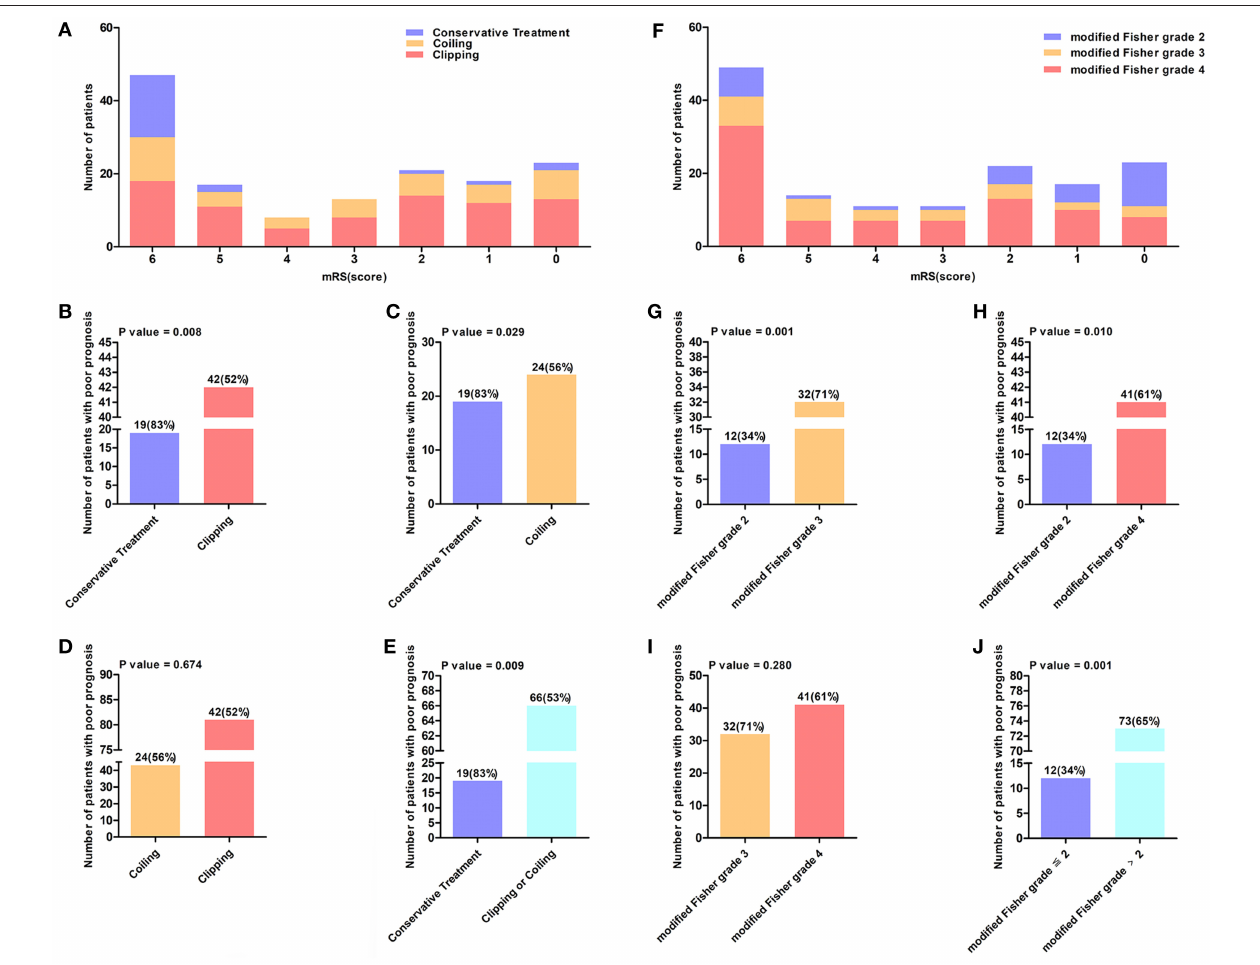
FIGURE 2 | (A) The distribution of mRS score of 147 poor-grade aSAH patients who accepted different treatment methods. The value above the histogram shows the number of patients with poor prognosis and their percentage, for instance, the interpretation of 19 (83%) in (B) is that 19 (83%) patients had a poor outcome among 23 patients who received conservation treatment. (B–E) Reflects the influence of different treatment methods on the prognosis of patients. (F) Shows the distribution of mRS score of 147 poor-grade aSAH patients in different modified Fisher grade. (G–J) Reflects the influence of different modified Fisher grade groups on the prognosis of